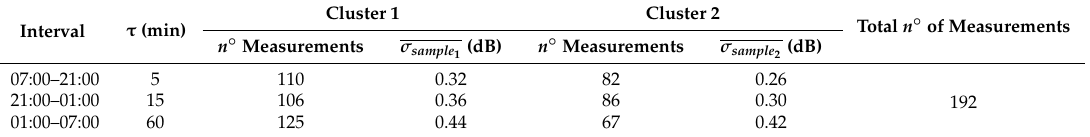
Table 3. Since the stratified sampling method represents an intrinsic error due to the finite number of measurements, we take the same value (mean value) σ sample Table 2. Mean expected deviation σ sample calculated within the three time intervals used in this work—T h = (07:00–21:00), (21:00–01:00), and (01:00–07:00)—for the three discretization times τ = (5, 15,